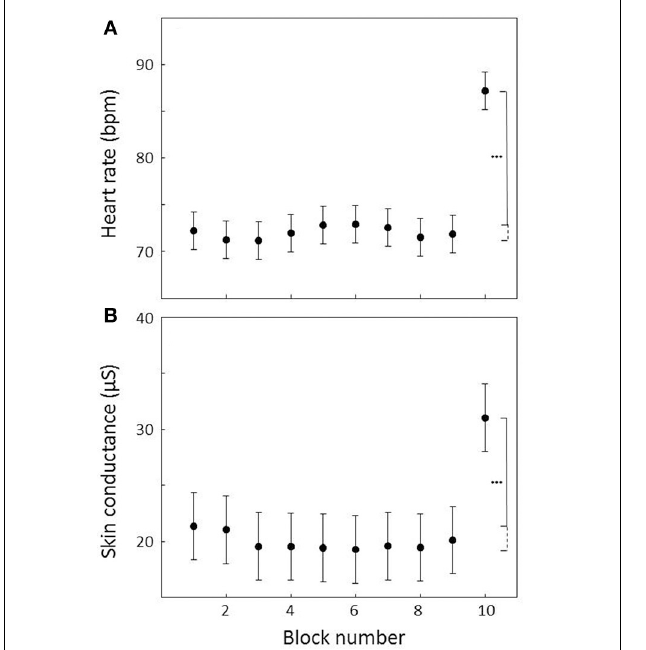
FIGURE 2 | Heart rate (A) and skin conductance (B) averaged across 1-min count-down blocks across all subjects. Block 10 is the count-down block following the sing-a-song sentence. Error bars indicate standard errors of the mean. Stars indicate that heart rate and skin conductance are significantly higher in block 10 compared to all other blocks at an alpha level of 0.001.